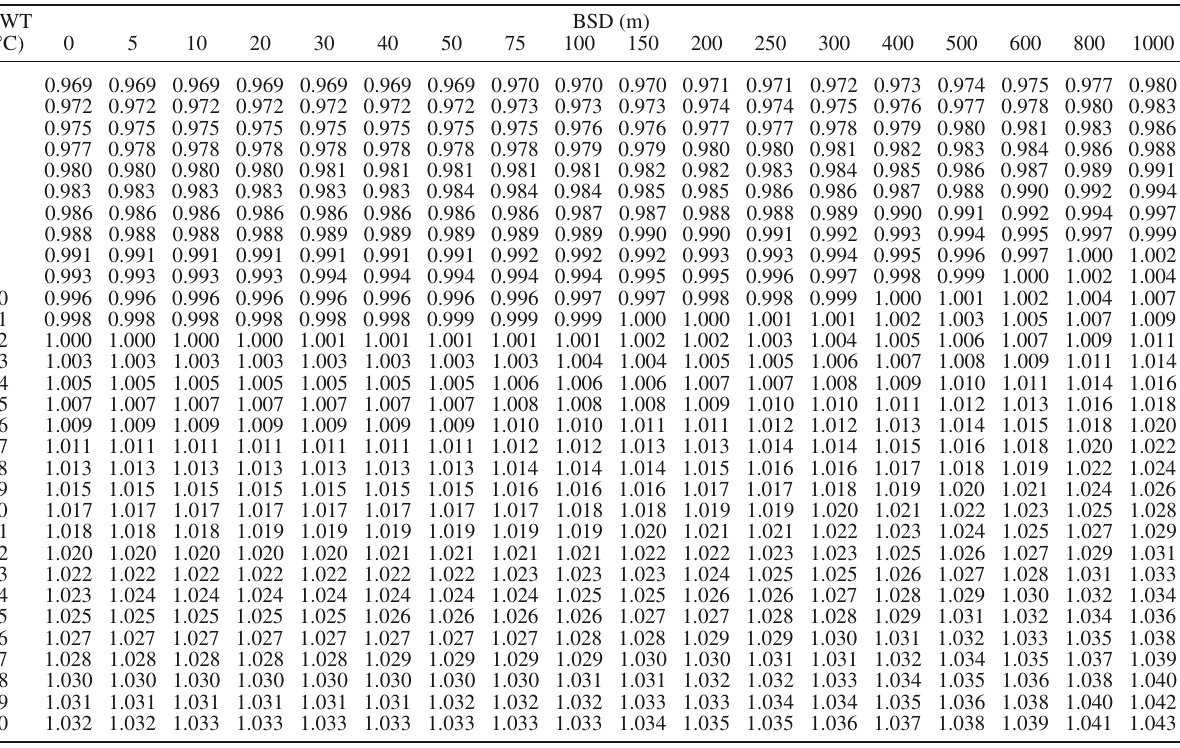
Table 1. – Sound compensation coefficient ( SCC ) calculated with the Del Grosso (1974) equation for different bottom sea depth (BSD) and sea water temperature (SWT) combinations. SWT BSD (m)